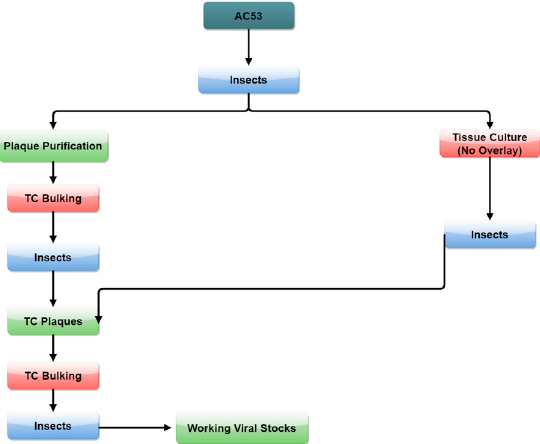
Figure 1. Isolation of H. armigera single nucleopolyhedrovirus (HaSNPV) strains in tissue culture (TC).